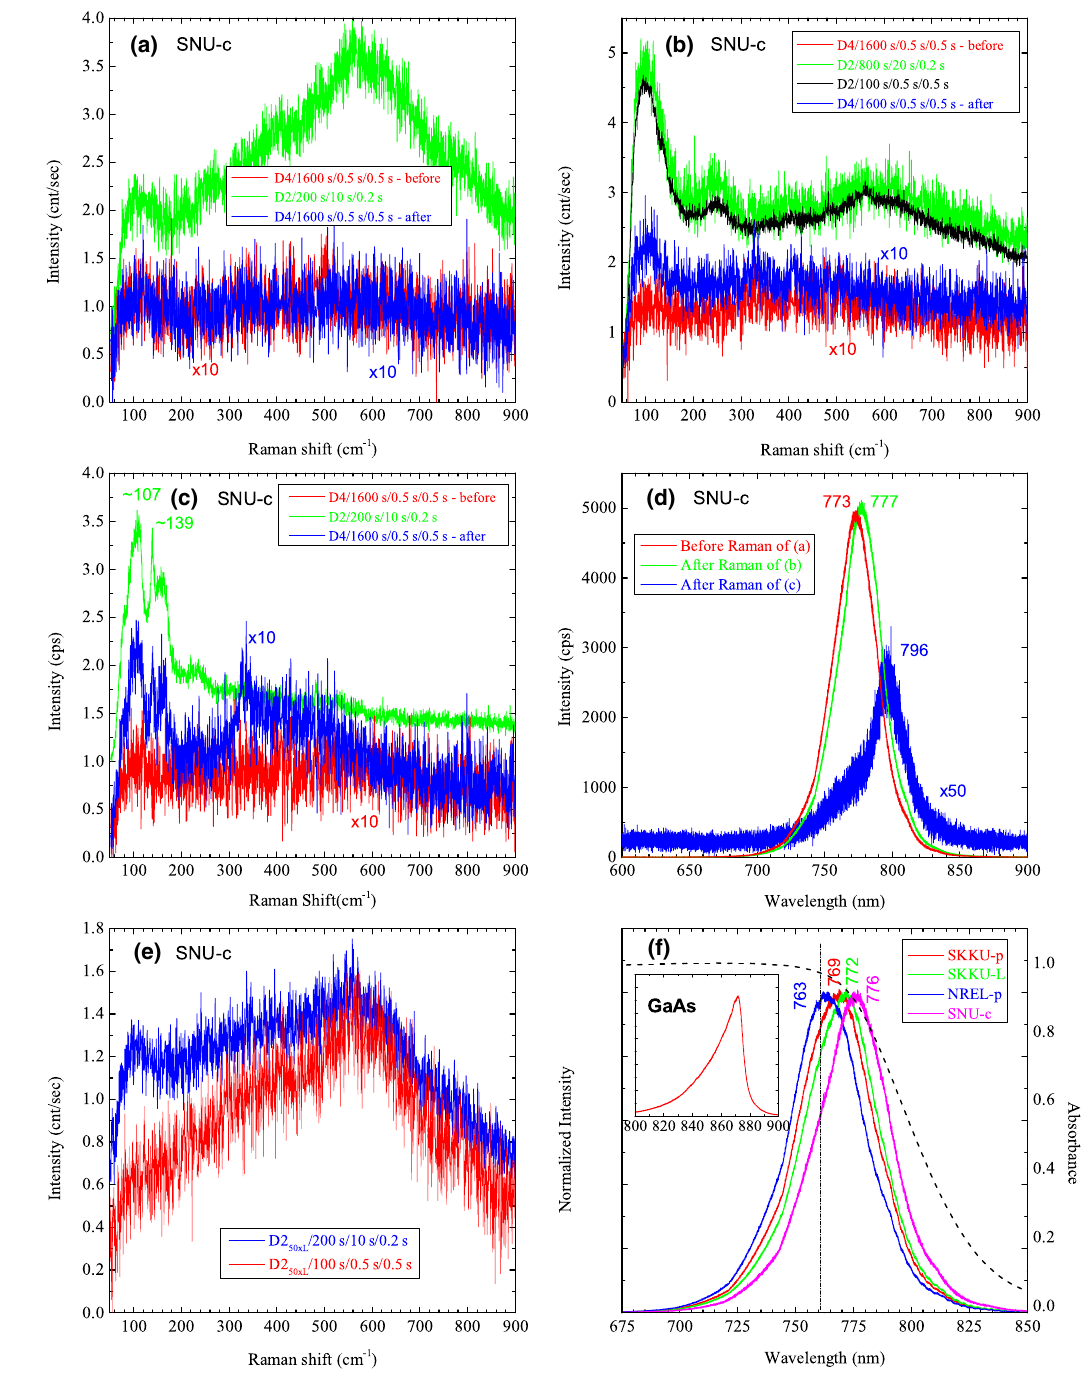
FIG. 4. Raman and PL spectra of SNU-c samples measured at different conditions. (a) – (c) Low-excitation density (D4) Raman spectra measured before and after different higher excitation density measurements. (d) D4 PL spectra measured before the Raman measurement shown in (a) and after the Raman measurements shown in (b) and (c). (e) Raman spectra measured at a moderately high excitation density D2 under different data collection conditions. (f) Comparison of the D4 PL spectra for four types of samples, SKKU-p, SKKU-L, NREL-p, and SNU-c, and an absorption spectrum of a SNU-c sample. The inset shows a room-temperature GaAs PL